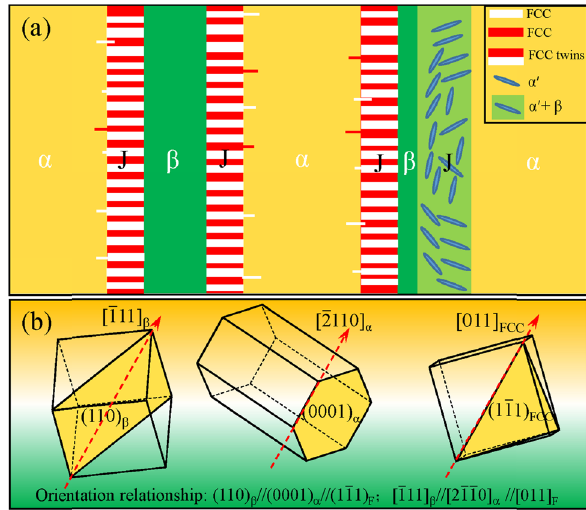
Figure 9: Schematic diagram of interface layer and FCC phase: ( a ) microstructure morphology and ( b ) orientation